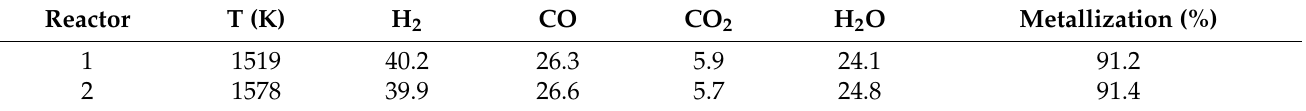
Table 11. Average gas composition and metallization degree at reactor exit.